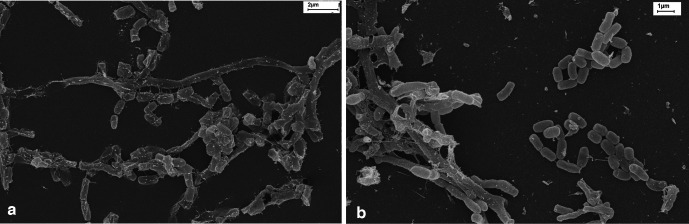
Scanning electron micrograph images of strain RB20T (left) and strain RB56T (right) cultivated at 28 °C on ISP3 agar for 14 days. Bars, 2 µm for RB20T and 1 µm for RB56T.